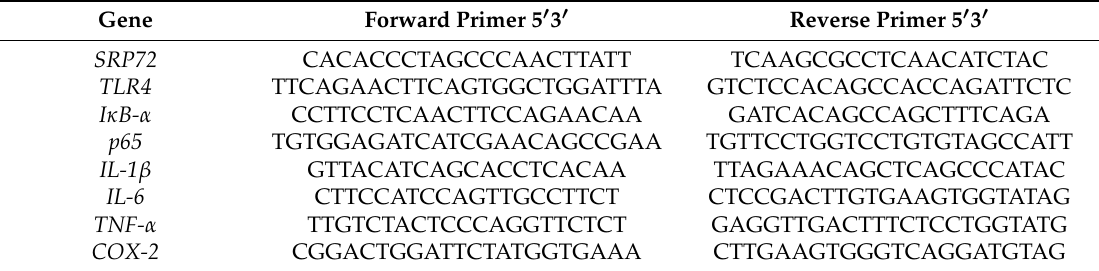
Table 3. Forward and reverse